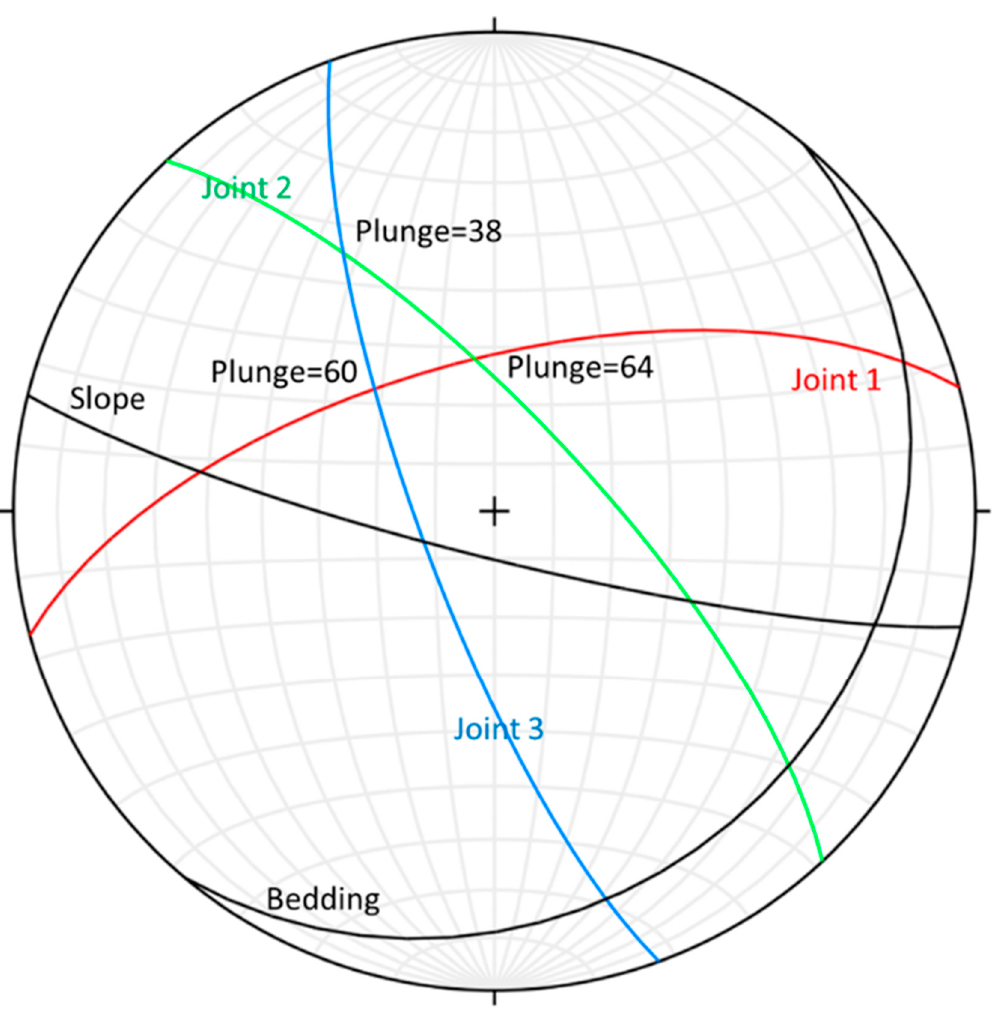
Figure 3. Attitudes of primary weak planes and stereographic projection in the study area.